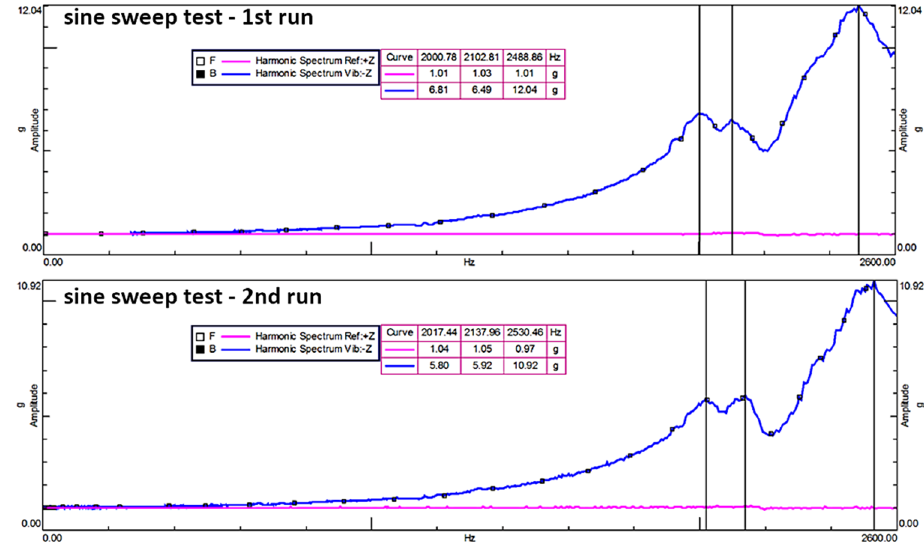
Figure 14. Results of the experimental tests for satellite antenna.